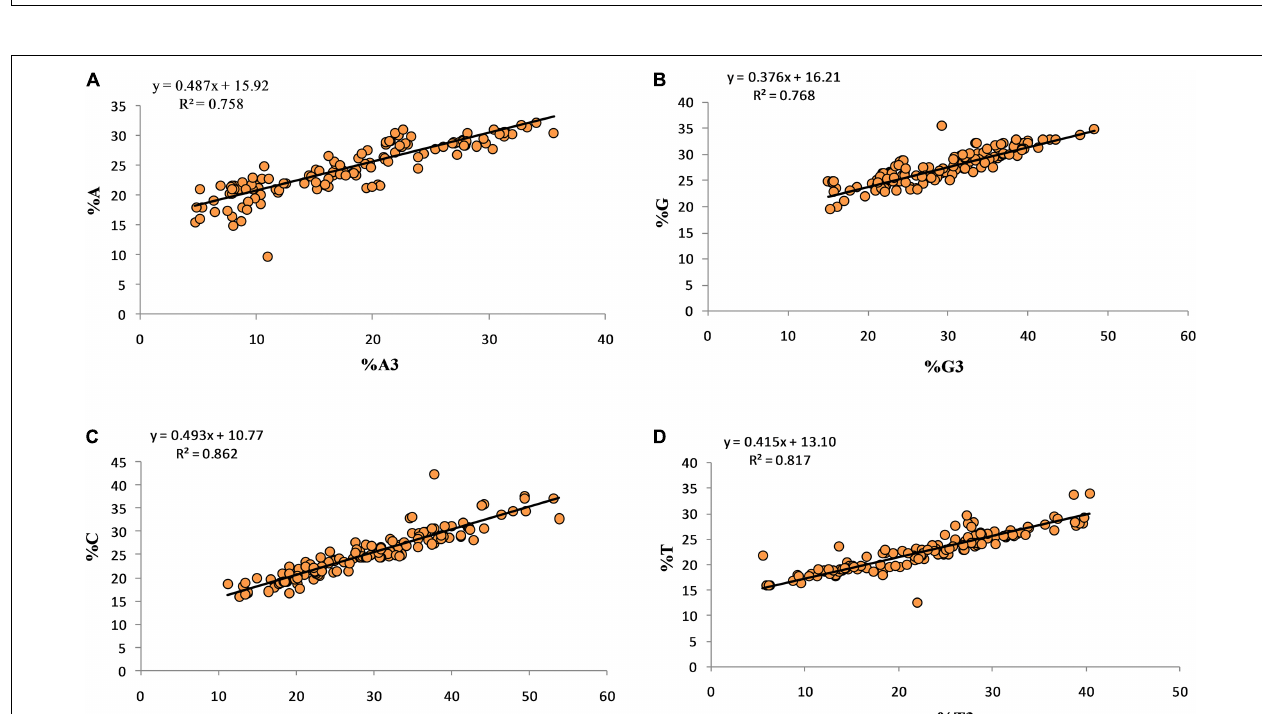
FIGURE 4 | Regression analysis for overall nucleotide content and nucleotide content at third position.